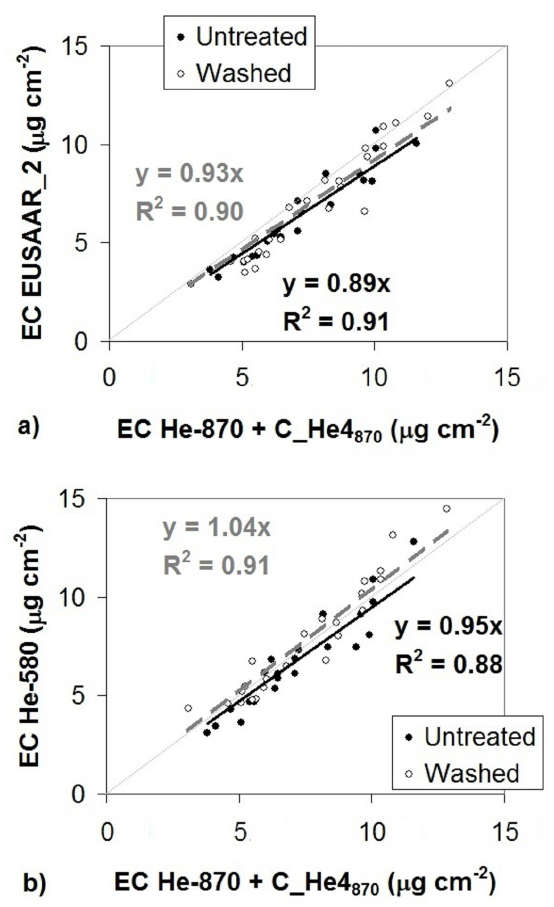
Fig. 3. EC measured by EUSAAR 2 (a) and He-580 (b) ) vs. EC concentration obtained by the He-870 protocol summed to the car- bon fraction evolving in the He4 870 (i.e. EC He-870+C He4 870